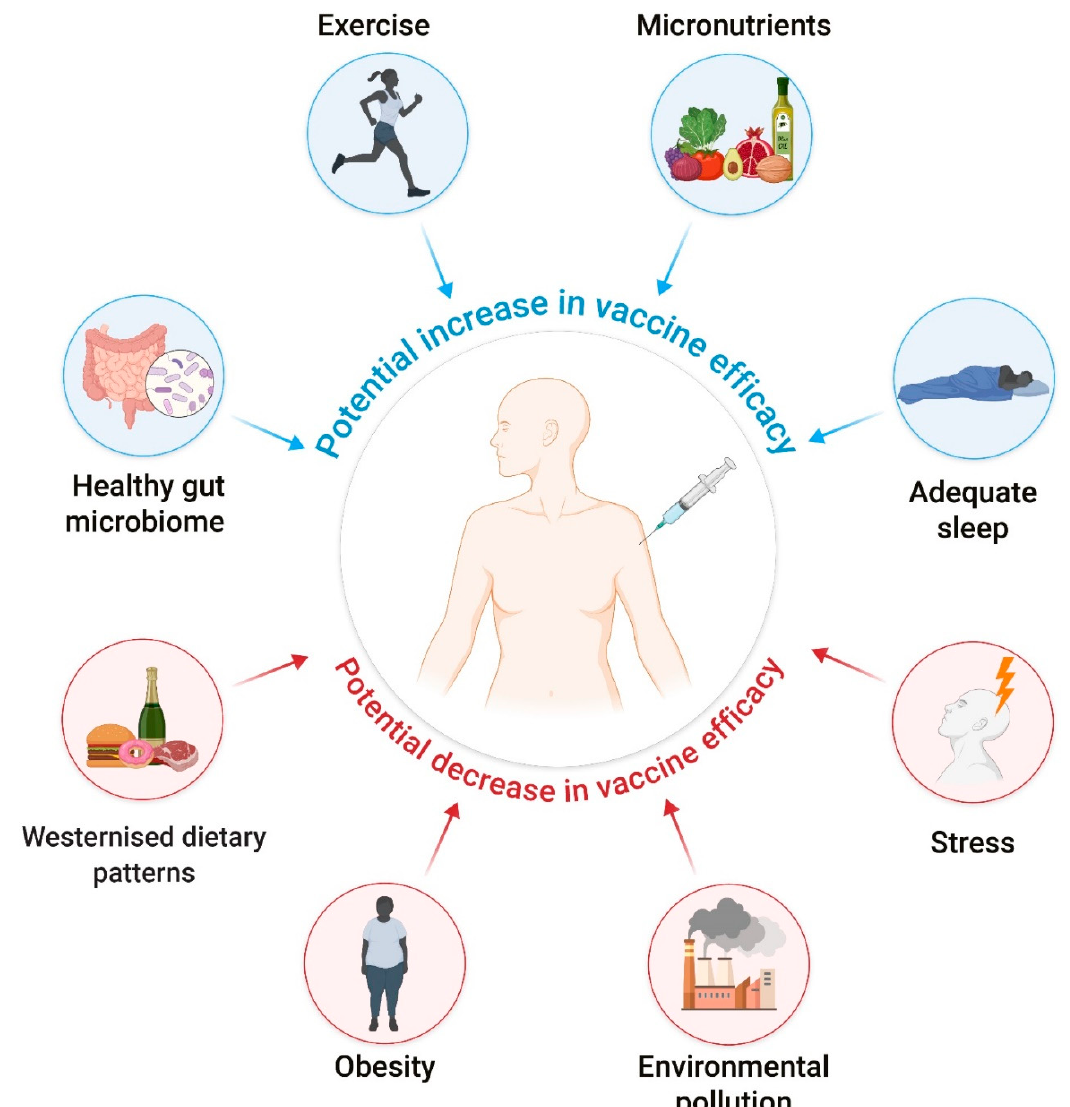
Figure 1. Summary of potential mechanisms underlying the positive and negative effects of the different exposome components on vaccine efficacy. Source: Self-elaboration based on the main results obtained in the scientific